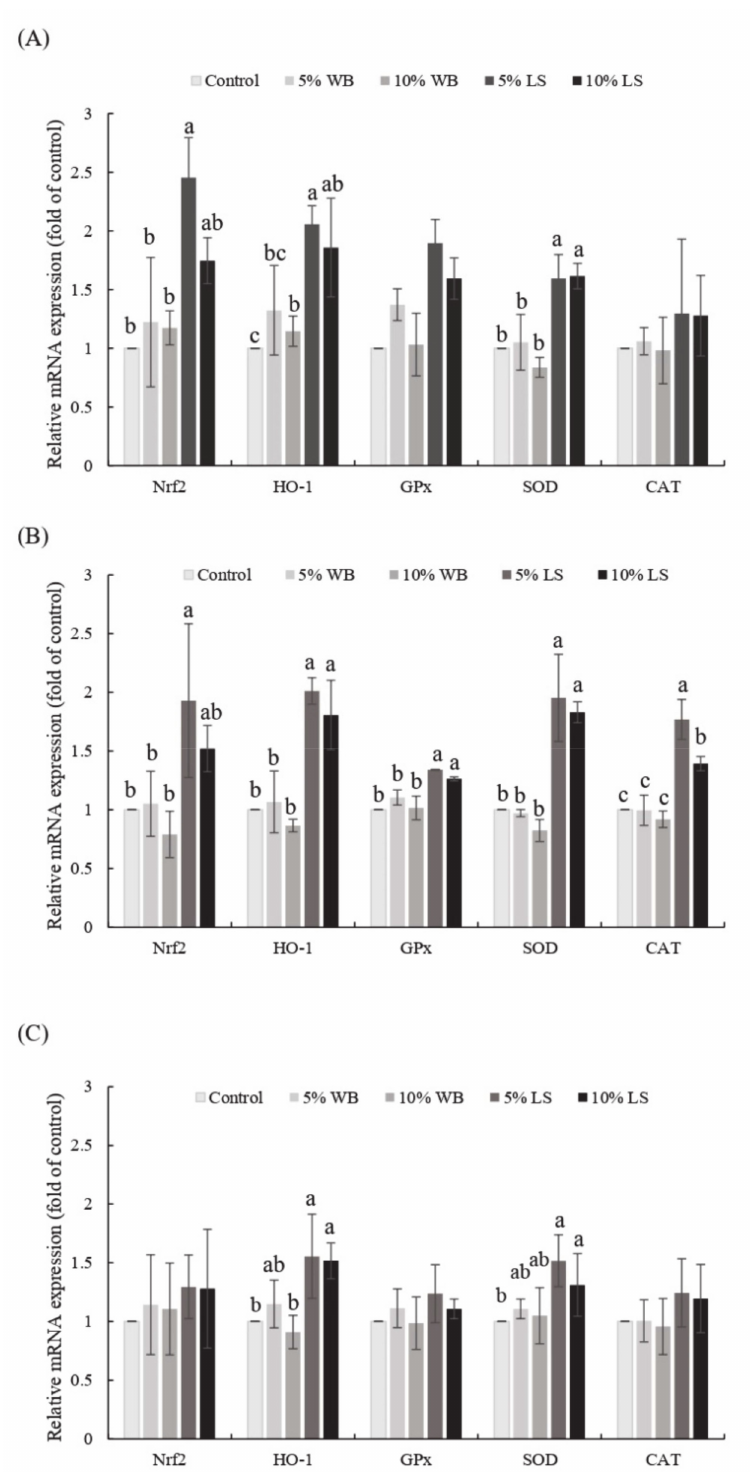
Figure 1. Effects of FL supplementation on mRNA expression levels of the selected genes related to antioxidant-status in ( A ) liver, ( B ) jejunum, and ( C ) ileum of 35-day-old broilers. Values are expressed as the mean ± standard deviation ( n = 6). a–c Means among groups without the same letter, within the same sampling day, are significantly different ( p < 0.05). WB: Wheat Bran; FL: Laetiporus sulphureus fermented